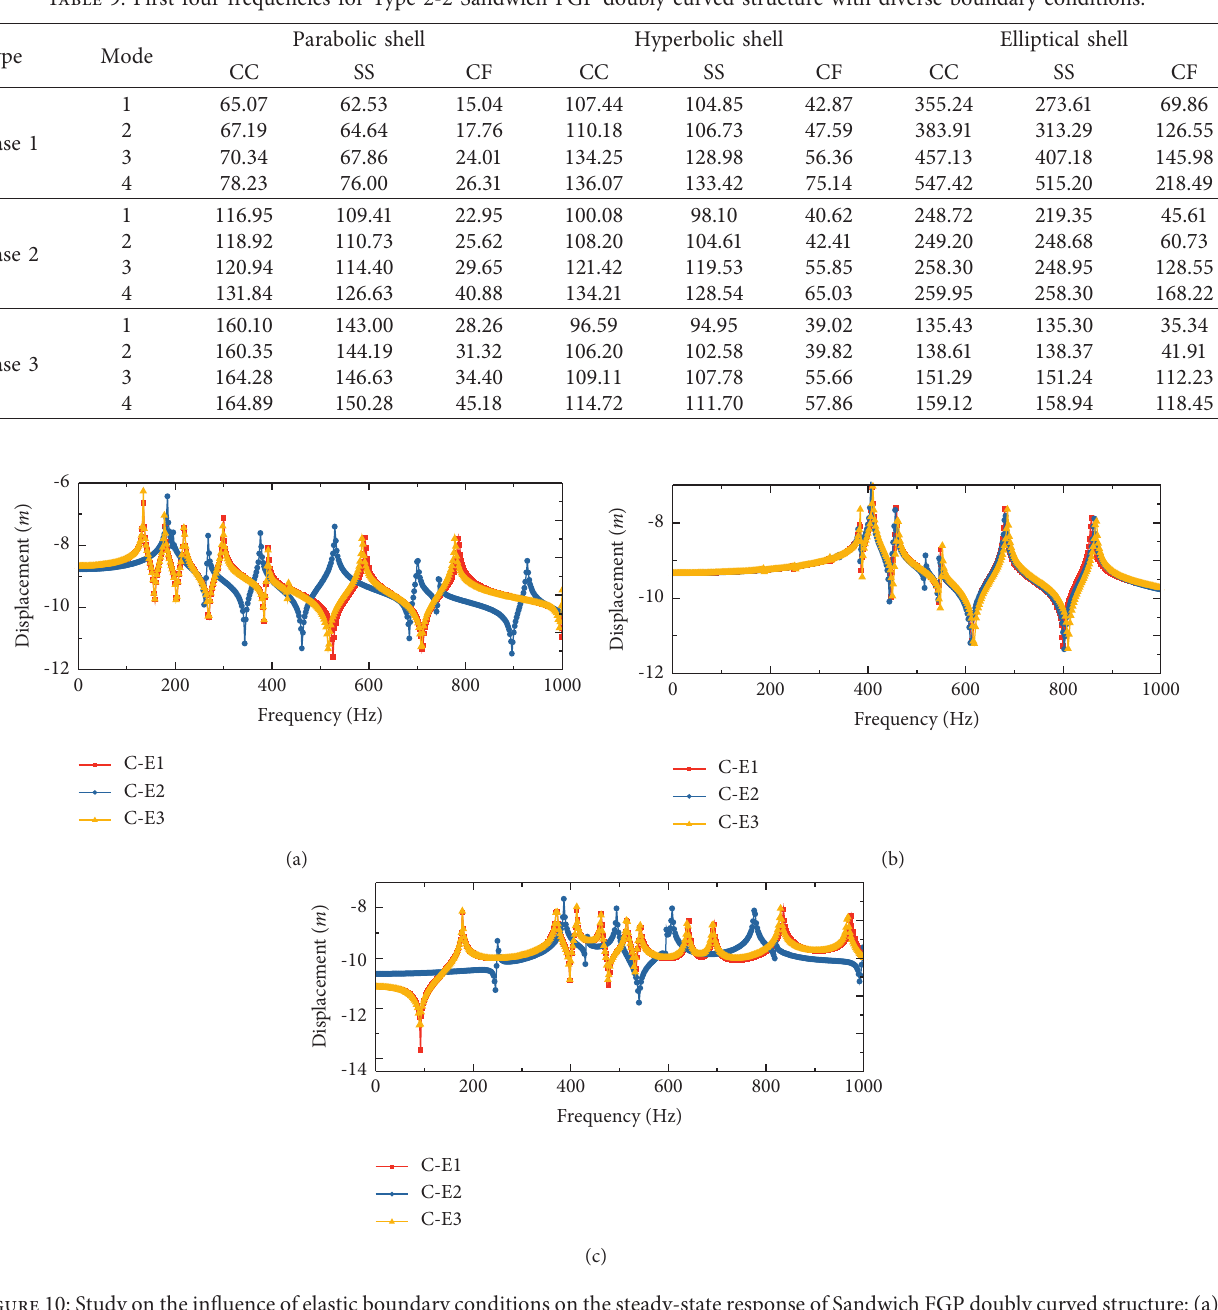
Figure 10: Study on the influence of elastic boundary conditions on the steady-state response of Sandwich FGP doubly curved structure: (a) Sandwich FGP paraboloidal shell; (b) Sandwich FGP hyperbolic shell; (c) Sandwich FGP elliptical